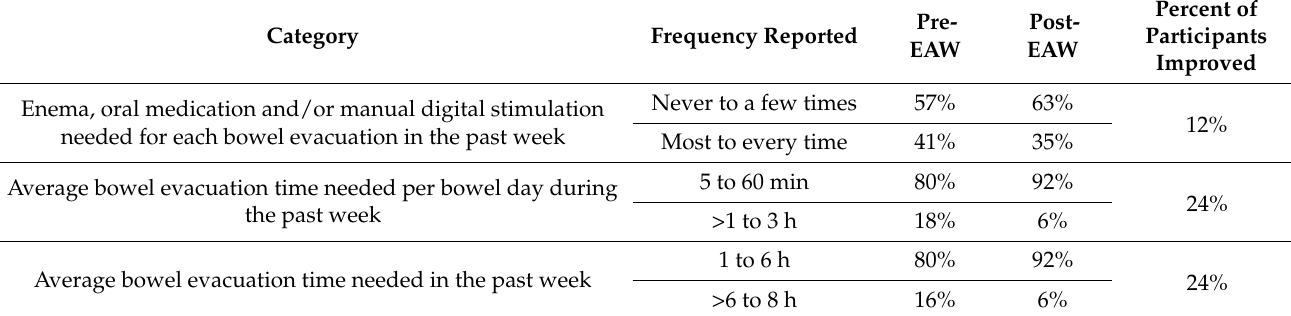
Table 1. Selected patient-reported outcomes from the 10Q Function Survey. Results from three of the 10Q questions were combined in the first category in the table in order to represent the degree of external assistance needed in order to accomplish a bowel evacuation. The other two categories represent results from one individual question from the 10Q. For each category, a new binary response was created by lumping responses in order to qualitatively compare pre -and post-EAW results. For the purpose of the results in the last column, improvement was defined as either reduction in external assistance or reduction in bowel evacuation time.